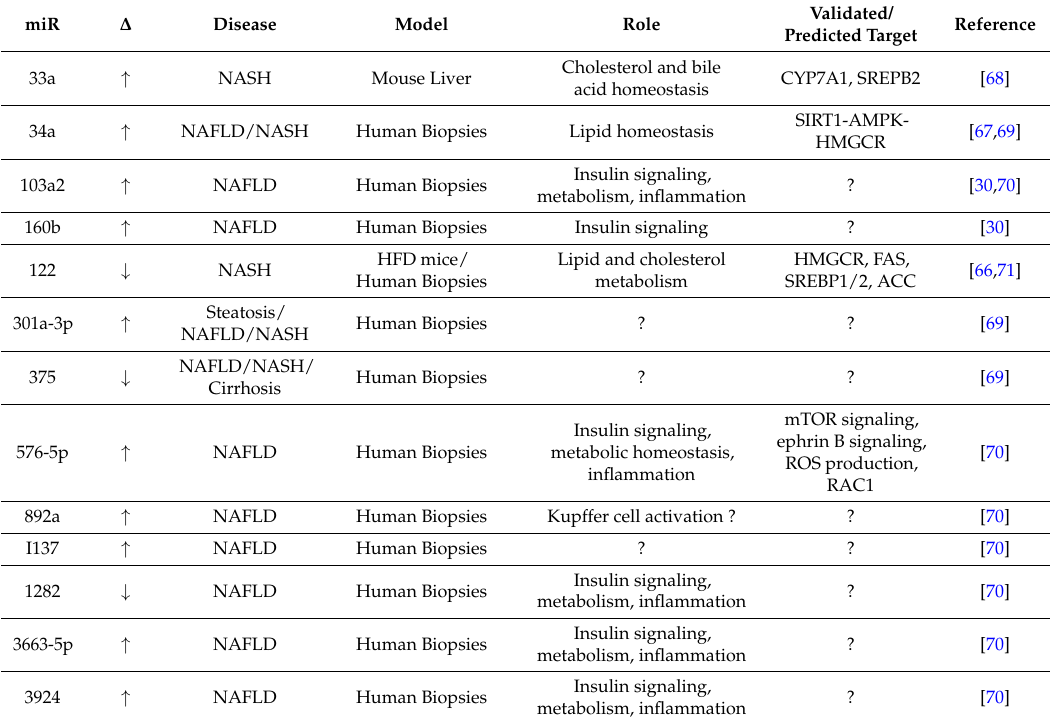
Table 1. Modulation of miRNA expression relevant to NAFLD/NASH. ∆ indicates up- ( ↑ )